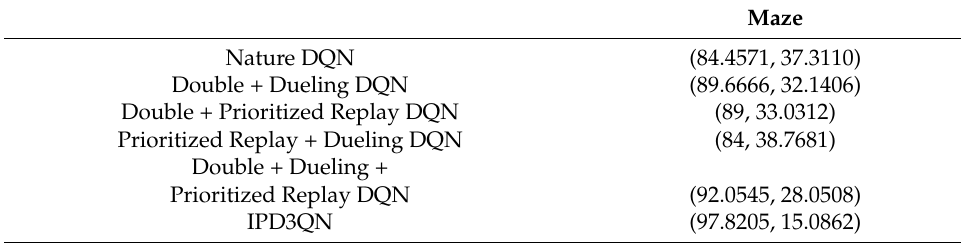
Table 7. Comparison Of Convergence Stability In Maze Environments.